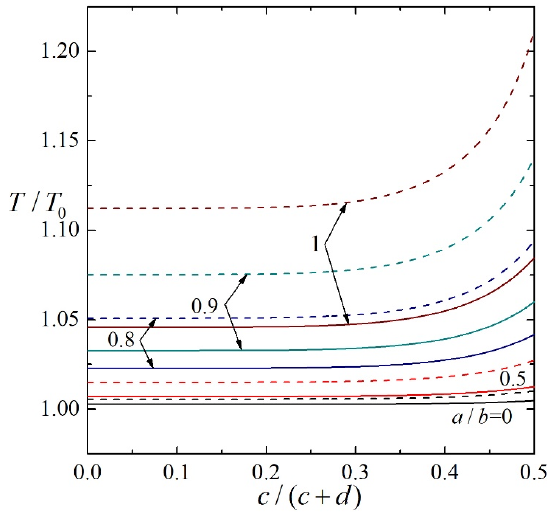
Figure 8. Normalized torque T / T 0 for a soft sphere rotating about a diameter perpendicular to two planar walls vs. the relative position parameter c / ( c + d ) with λ b = 1. The solid and dashed curves denote cases of b / c = 7/10 and b / c = 9/10, respectively. For fixed values of / T T for the confined soft spherical particle undergoing rotation 0 increases monotonically with an increase in the ratio of the core-to-particle radii where the limits denote a porous sphere and an impermeable